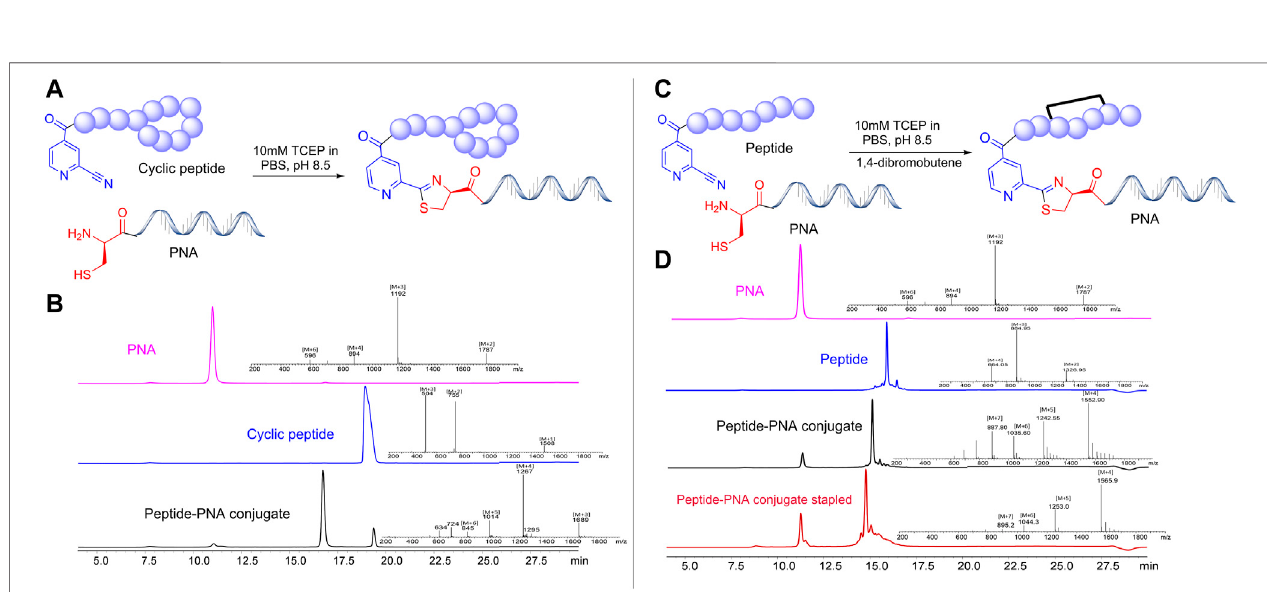
FIGURE 3 | Synthetic strategies and ef fi ciency of Cys-CINA in the synthesis of complex peptide-PNA conjugates. (A) Synthesis of cyclic peptide-PNA conjugate: CINA-OctGly-Dab-Thr-Dab-Dab*-Dab-D-Phe-Leu-Dab-Dab-Thr*(1.2equivalents),PNA:Cys-PEG-Cyt-Thy-Cyt-Ade-Thy-Ade-Cyt-Thy-Cyt-Thy-Thy-Gua-Lys-NH2(1 equivalent),10 MTCEP, PBS,pH7.4. (B) AnalyticalHPLCspectraforpolymyxin,PNA andcrudepolymyxin-PNAconjugate. (C) “ One-pot ” synthesisofthioethercross- linked cathelicidin-PNA conjugate: CINA-PEG-Val-Cys-Lys-Arg-Trp-Lys-Lys-Trp-Lys-Arg-Lys-Trp-Lys-Lys-Trp-Cys-Val-NH2 (1. 2 equivalents), PNA: Cys-PEG- Cyt-Thy-Cyt-Ade-Thy-Ade-Cyt-Thy-Cyt-Thy-Thy-Gua-Lys-NH2 (1 equivalent) 10 M TCEP, PBS, pH 7.4, 1,2-dibromobutene. (D) Analytical HPLC spectra for linear cathelicidin,PNA,crudecathelicidin-PNAconjugate,and insitu side-chaincross-linking.[TCEP:tris(2-carboxyethyl)phosphine,PEG:8-Amino-3,6-DioxaoctanoicAcid, PBS: phosphate buffer